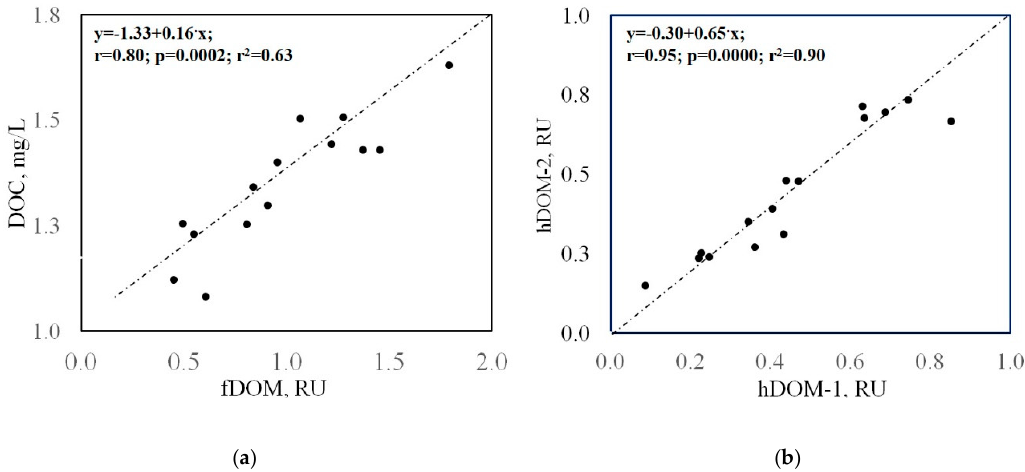
ground ice (TGI) samples are marked with an asterisk. are marked with an asterisk. Geosciences 2020 , 10 , x FOR PEER REVIEW